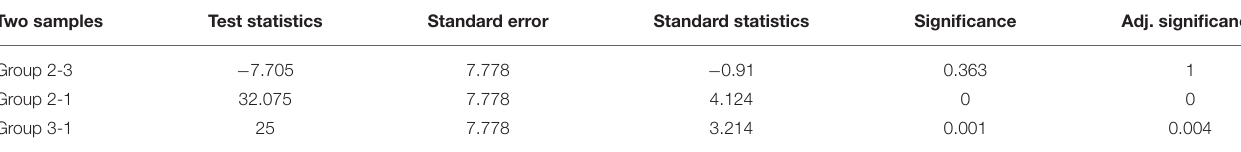
TABLE 5 | Comparison of